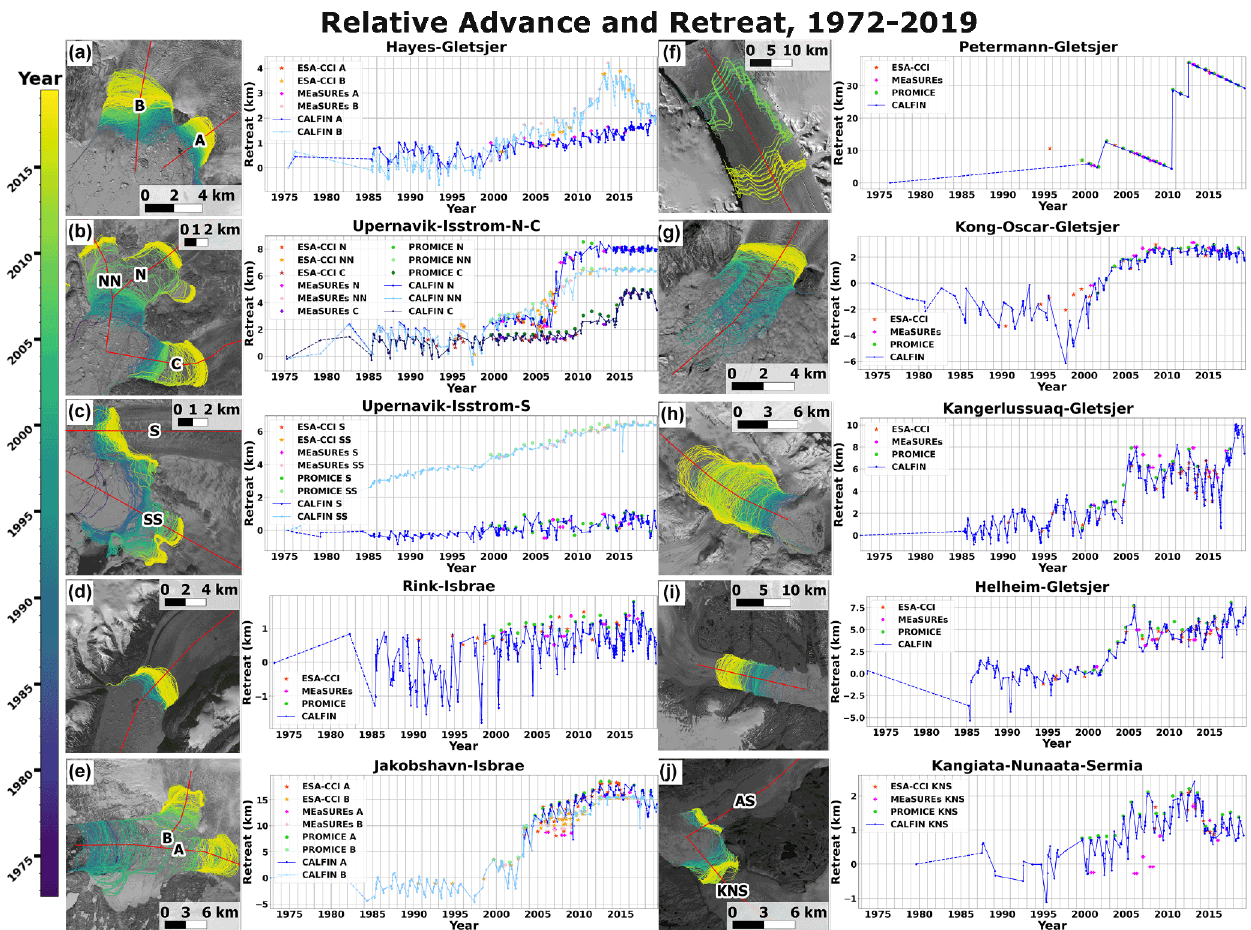
Figure 13. Terminus advance and retreat over time. (a–j) Basin setup (left) and graph (right) for 10 high-discharge basins. Positive length change represents retreat relative to the earliest position along the centerlines in red. Note the seasonal variations captured by CALFIN, in blue. Time series for other studies span 1990–2016 (ESA-CCI), 2000–2017 (MEaSUREs), and 1999–2019 (PROMICE). Note the seasonal variations shown by the solid lines and the dotted lines from 1972–1985 that indicate a lack of such seasonal observations. Also note that the vertical axis scaling is applied differently for each graph to highlight seasonal